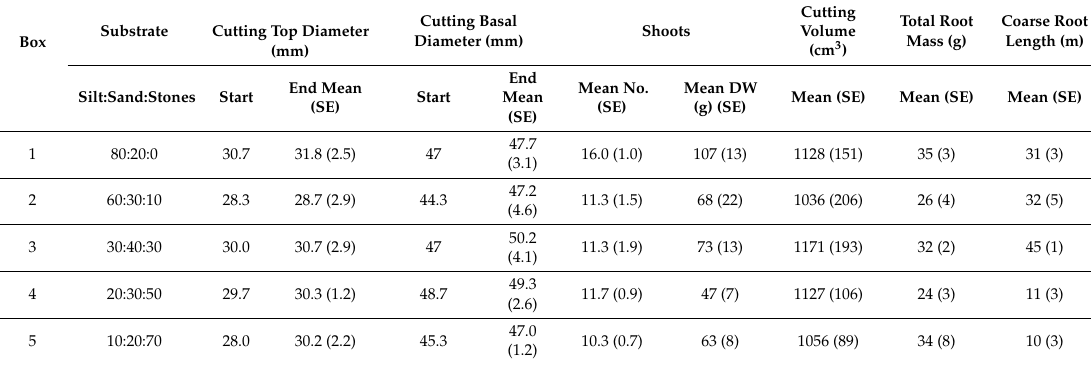
Table 2. Growth in cutting diameter and shoot biomass during the